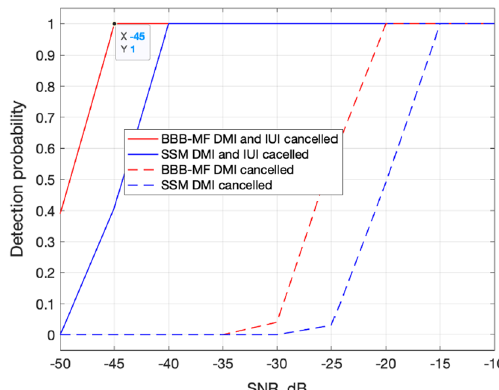
Fig. 7 Detection probability versus